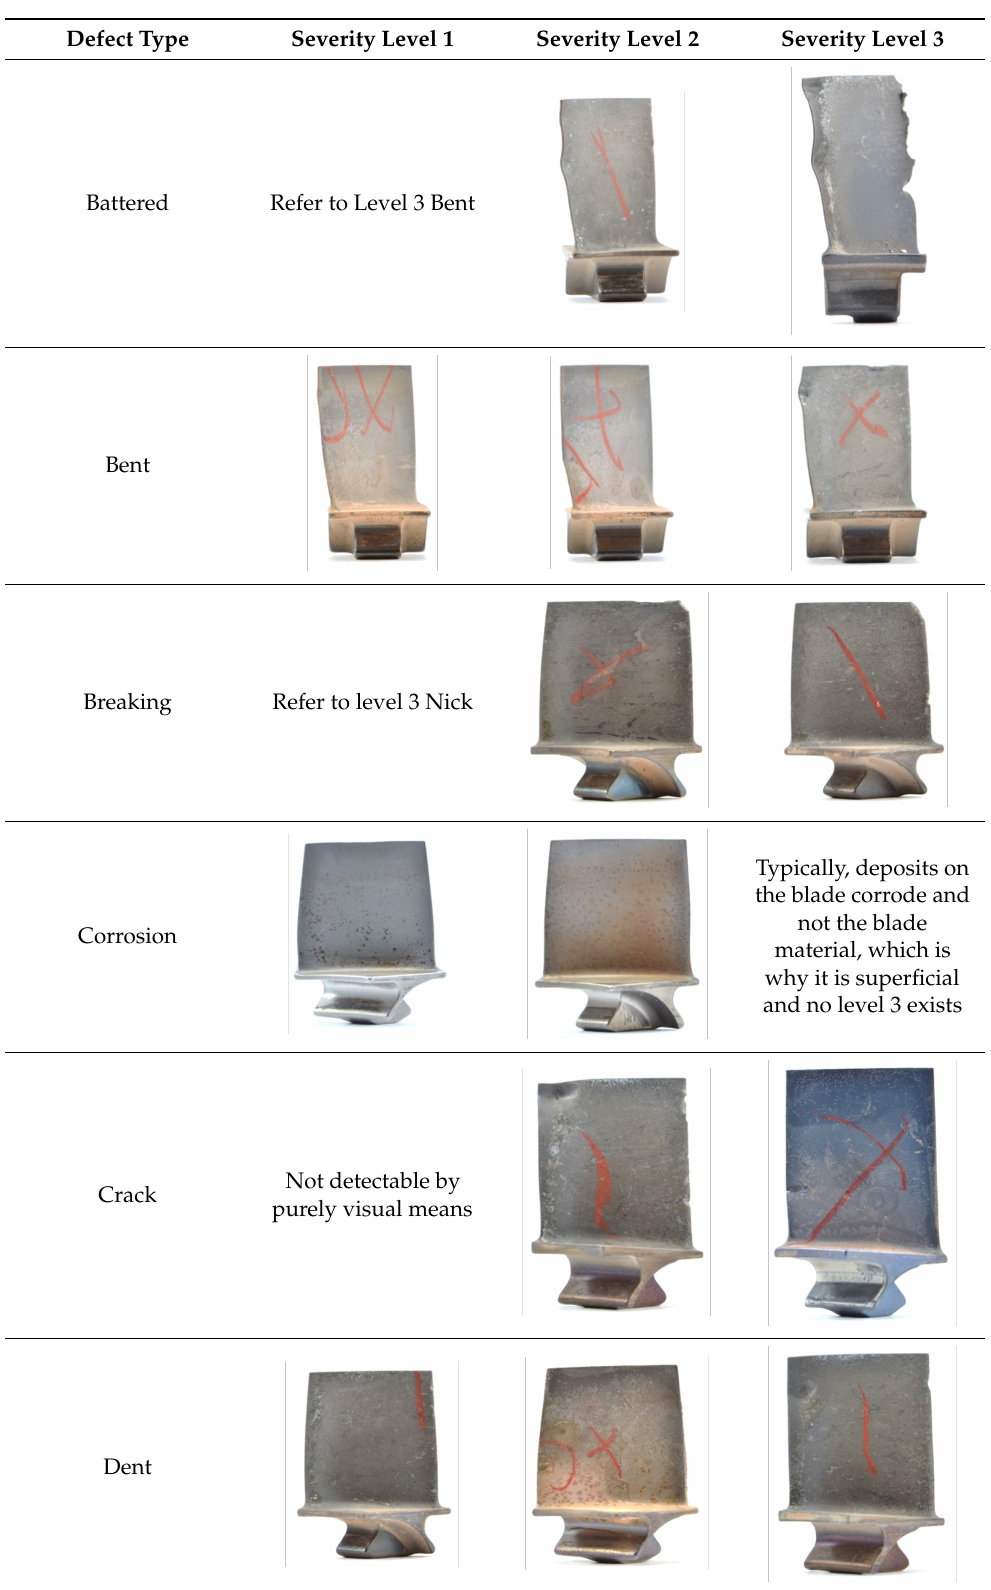
Table 8. Severity levels of growth